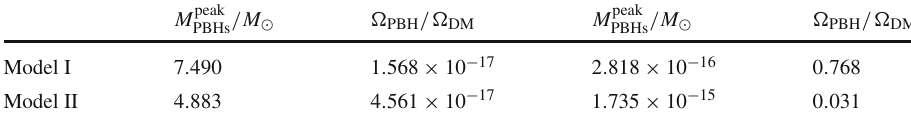
Table 2 The numerical results of PBHs production for the two models